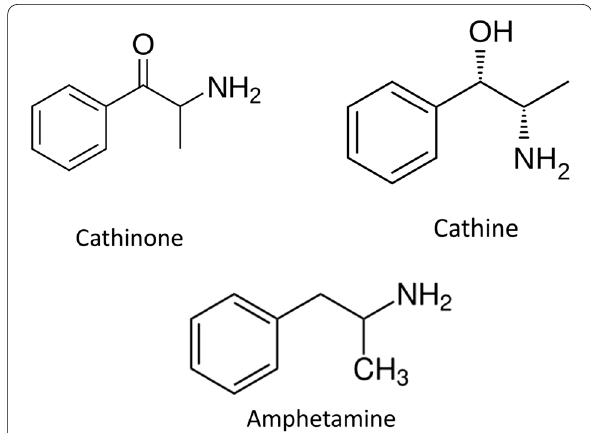
Fig. 1 Cathinone is a monoamine alkaloid discovered in Khat and is chemically related to cathine and